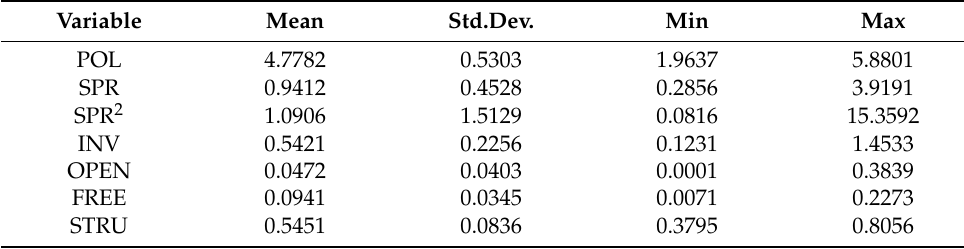
Table 2. Descriptive statistics of the panel